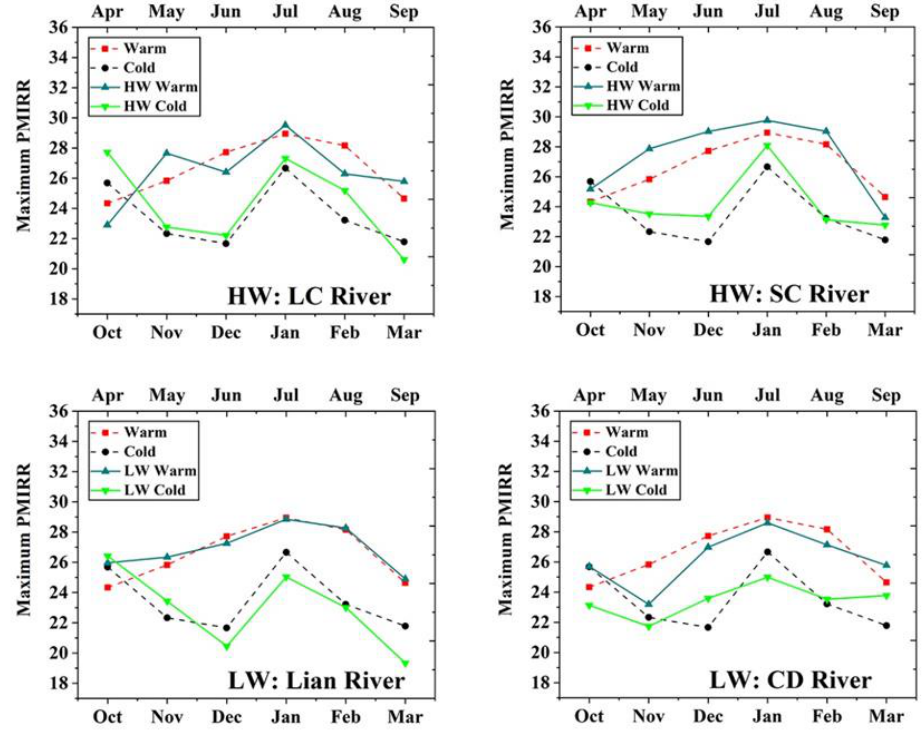
Figure 7. Monthly IR values and change rates in the warm and cold seasons. The solid line for high-elevation water bodies (HWs)/low-elevation water bodies (LWs) is one water body, and the dotted line represents the average of all water bodies.